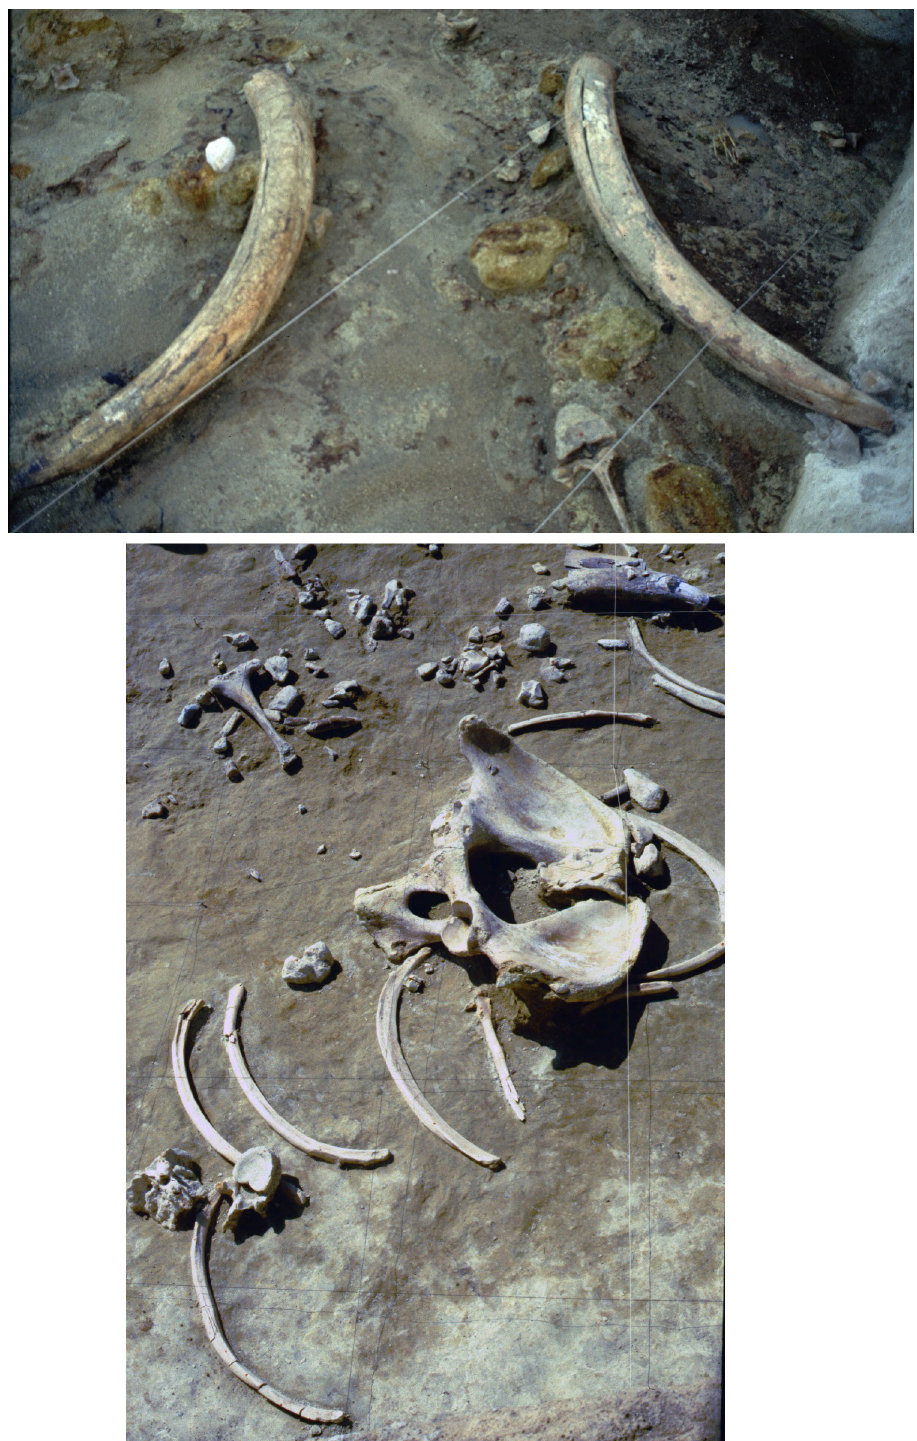
Fig 4. CdG excavation photo. Some elements were in anatomical association. Top: two tusks clearly belonging to the same animal. Bottom: elephant pelvis with the two hip bones in association.